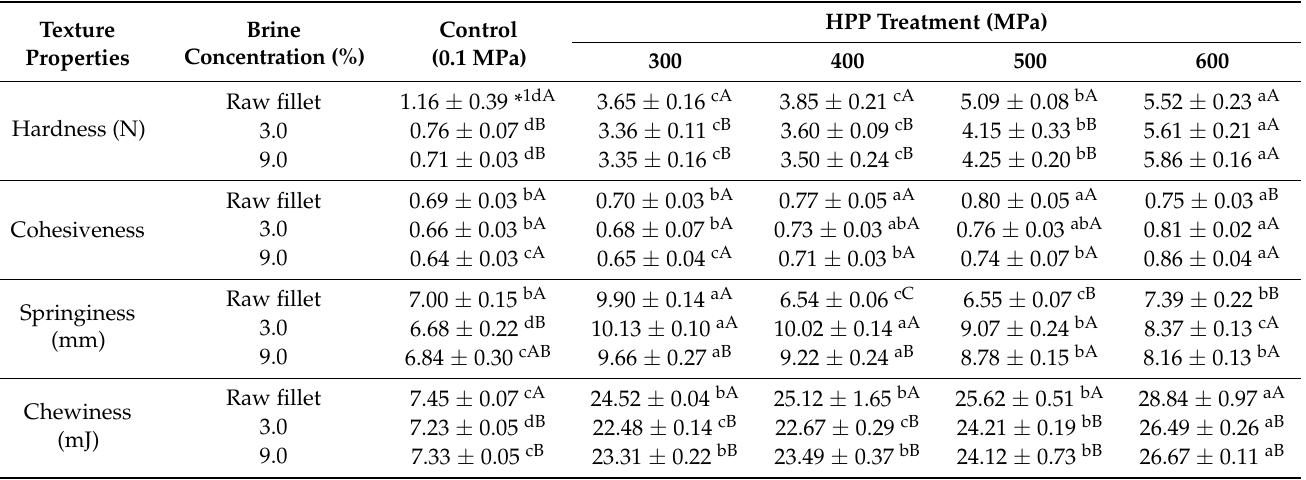
Table 3. The texture properties of mackerel fillets after the brine salting of 3.0% and 9.0% for 90 min at 4 ◦ C, and then pressurization at 300, 400, 500, and 600 MPa for 5